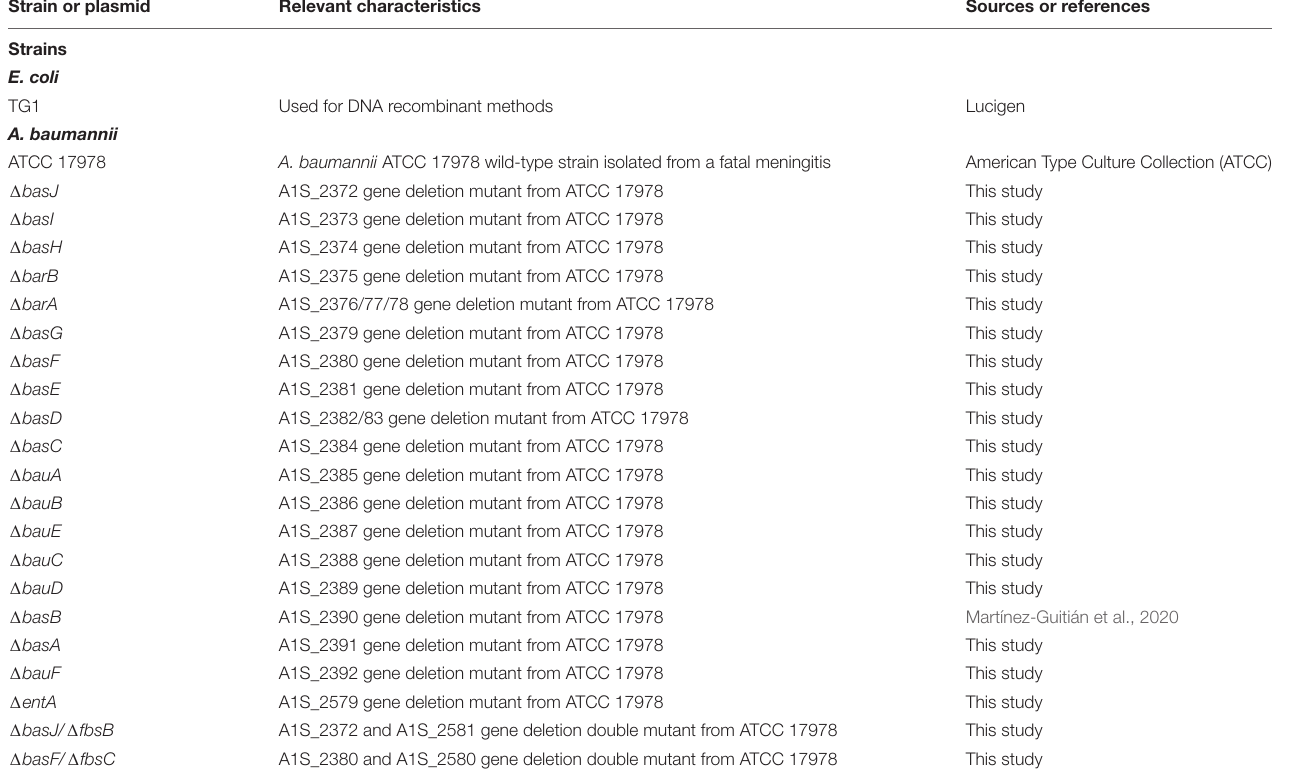
TABLE 1 | Bacterial strains used in this